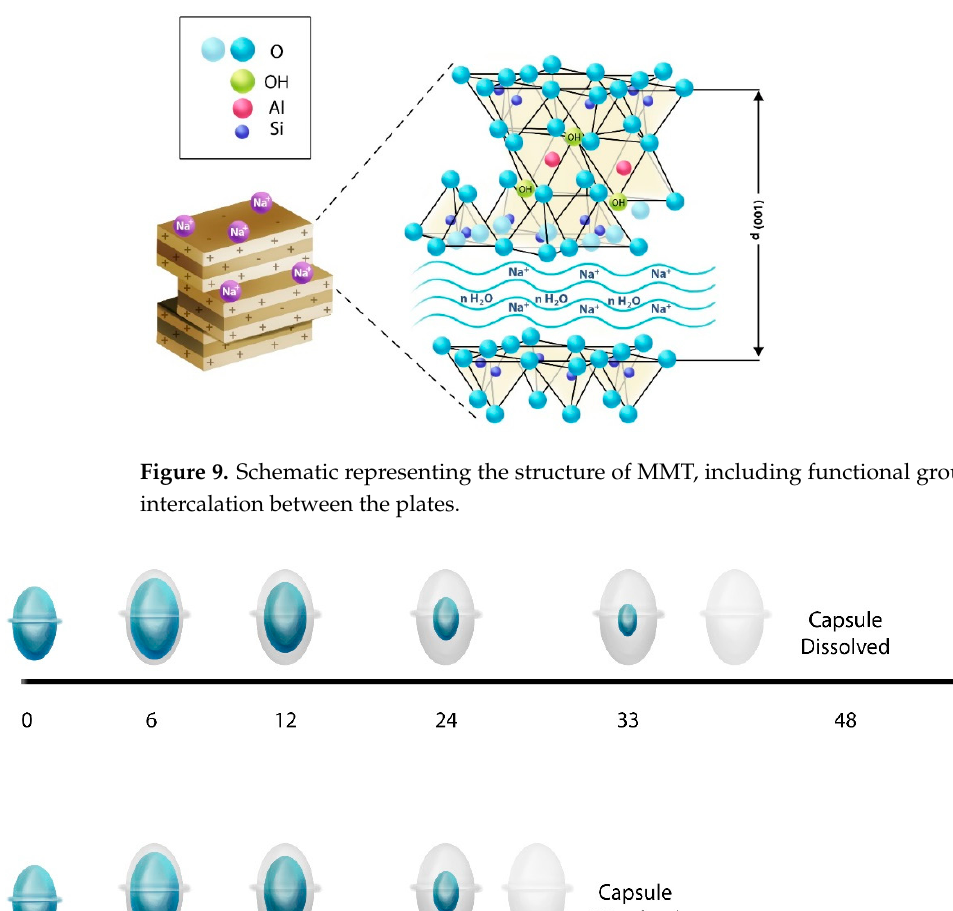
Figure 10. Based on the real-time imaging (Figure 7), capsule disintegration pattern at specific time-points.